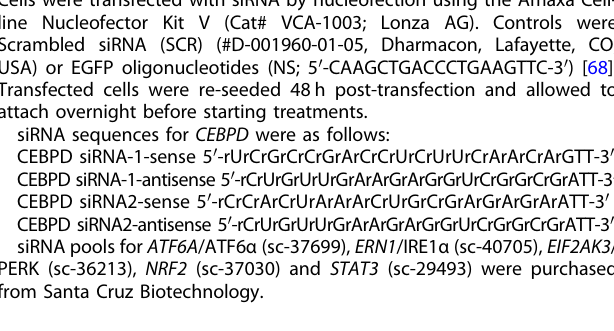
Fig. 6 Transient exposure to Thapsigargin triggers long-term secretion of CXCL8 and CCL20 and modulation of immune and tumor cells. a , b Western blot analysis of the indicated proteins in (a) MDA-MB-435S and (b) KPL-4 cells treated with 100 nM Tg for 30 min followed by removal of Tg and collected at indicated times thereafter (0 h = pulse-treated with DMSO). c , d qRT-PCR analysis of CXCL8 and CCL20 mRNA levels in c MDA-MB-435S and d KPL-4 cells treated as panels a and b . e , f Enzyme-linked immunosorbent assay ( ELISA ) for e CXCL8